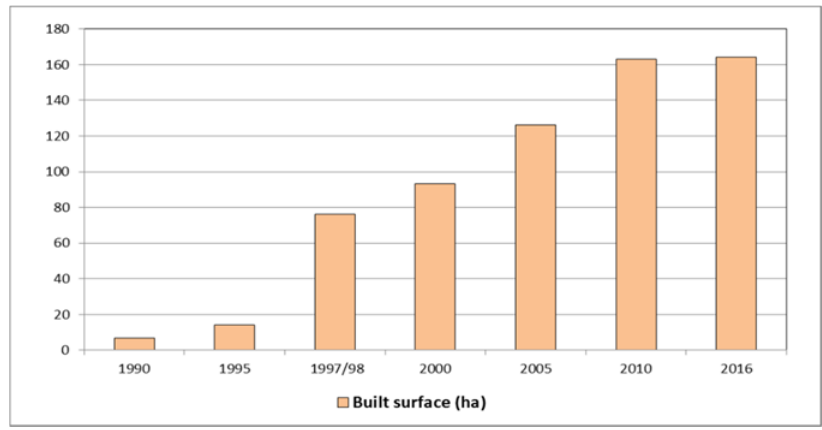
Figure 4. Evolution of the land surface built in Altorreal since 1990.